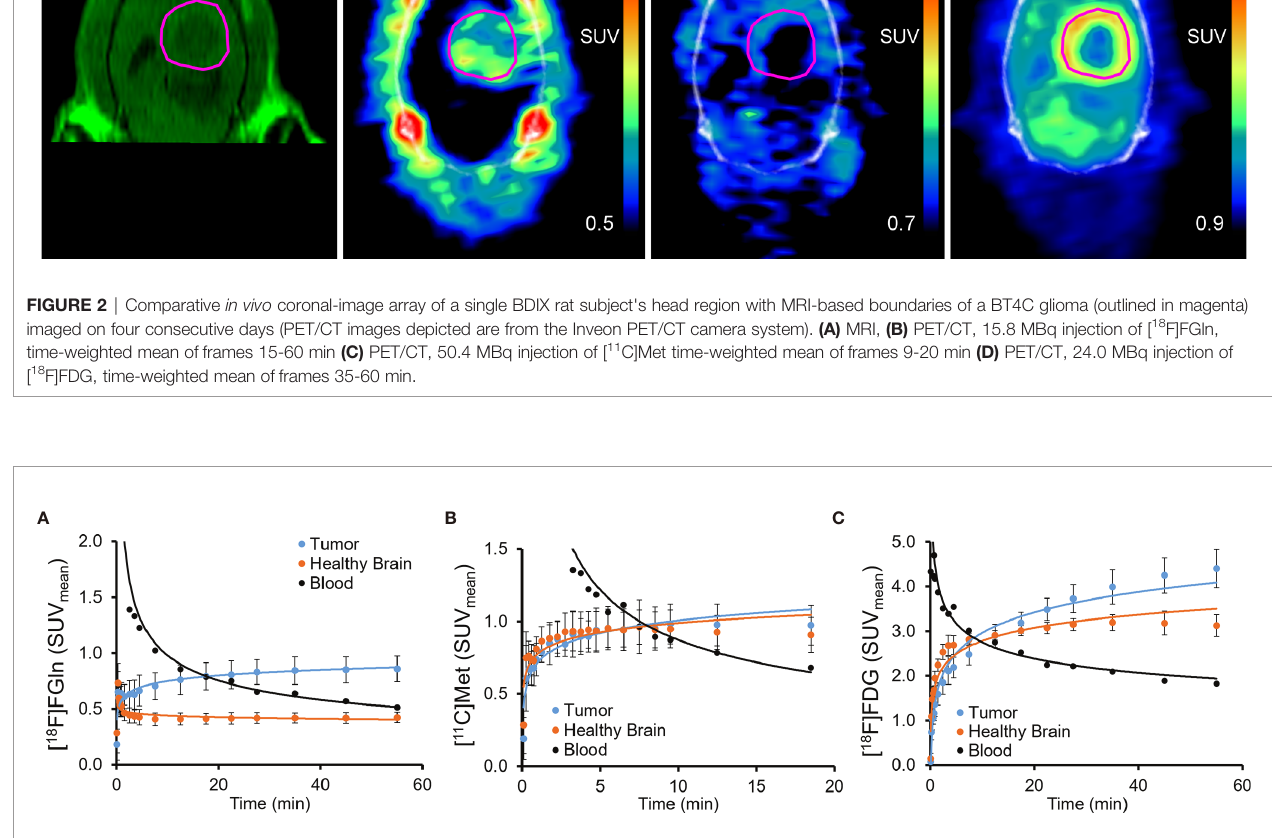
FIGURE 3 | Average PET image time-radioactivity curves of all subjects' PET/CT images (A) [ 18 F]FGln (n = 13), (B) [ 11 C]Met (n = 12), (C) [ 18 F]FDG (n = 7). Standard deviation error bars on blood radioactivity curves were omitted for clarity (shown in Supplementary Figure 7